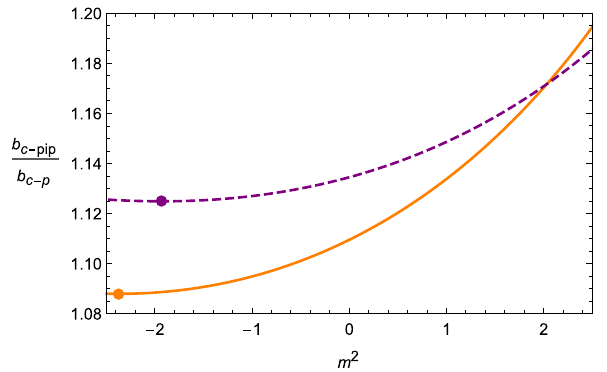
Fig. 3 b c − pip / b c − p − m 2 relations.Thesolidorangelineisforthecase with m 2 p = 0 and the dashed purple line for the case with m 2 p = − 3 / 16, with the two points on each line indicating the minimum